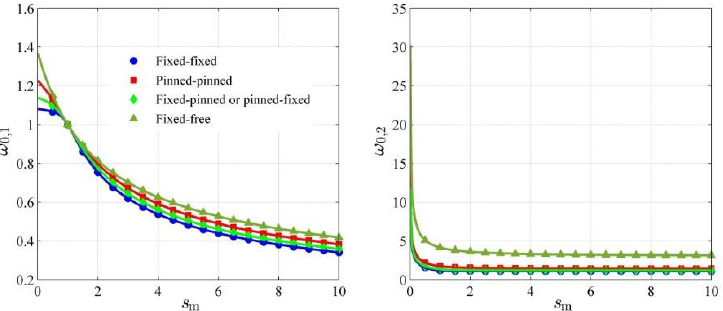
Figure 7. Frequency ratios in two sub-modes corresponding to the 1st basic mode versus contact stiffness ratio for different boundary conditions when 𝑠 e = 100 and 𝑠 k = 1 .